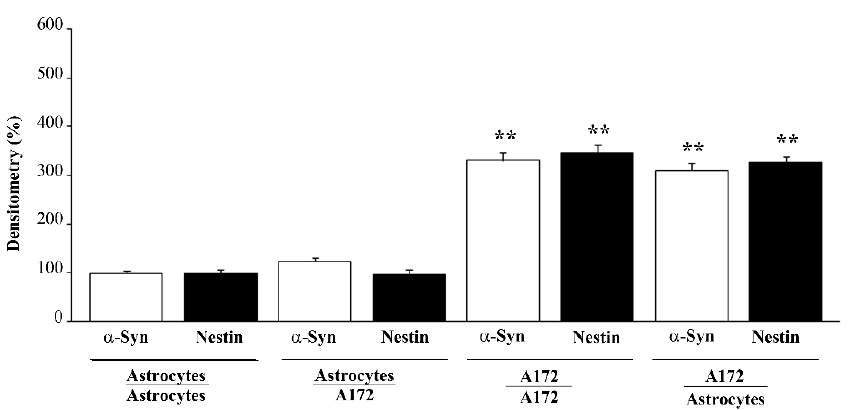
Figure 12. Densitometry of α -syn and nestin in co-cultures of astrocytes and A172 cells in baseline conditions and following rapamycin administration. Graphs report densitometry for α -syn and nestin immuno-fluorescence in co-cultures of astrocytes and A172 cells, both in baseline conditions ( A ) and following 100 nM rapamycin administration ( B ). These data are obtained from astrocytes co-cultured with astrocytes, astrocytes co-cultured with A172 cells, A172 cells co-cultured with A172 cells, and A172 cells co-cultured with astrocytes. Data are given as the mean percentage+S.E.M. of optical density for each experi-mental group (assuming astrocytes co-cultured with astrocytes as 100%) obtained from N = 30 cells per group. * p < 0.05 compared with astrocytes co-cultured with astrocytes; ** p < 0.05 compared with astrocytes co-cultured with A172 cells. Similar to immuno-fluorescence, immuno-peroxidase for α -syn decreases when the trans-well co-cultures of astrocytes are exposed to rapamycin (Figure 13).